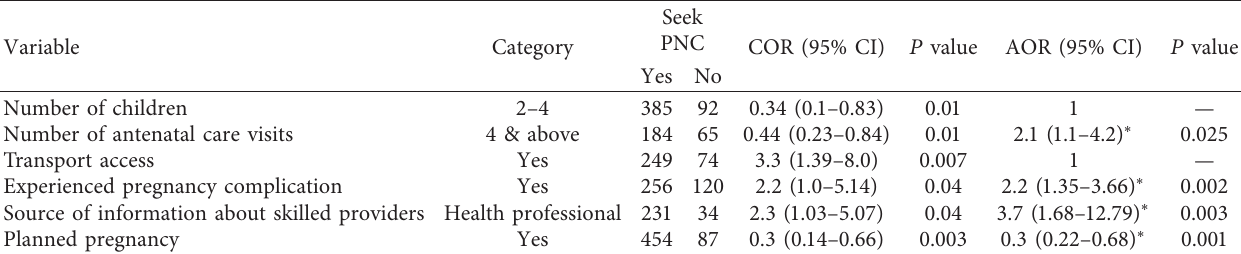
Table 7: Binary logistic regression model to examine the association of postnatal care services among study participants.